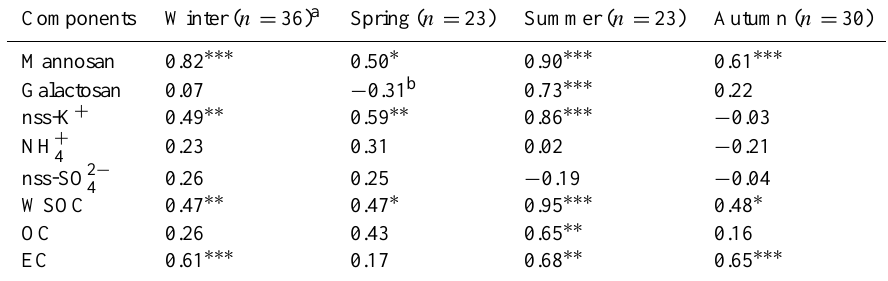
Table 3. Linear correlation coefficients ( r) between levoglucosan and other parameters including the other two anhydrosugars, major ions and carbonaceous components in Okinawa aerosols in different seasons.